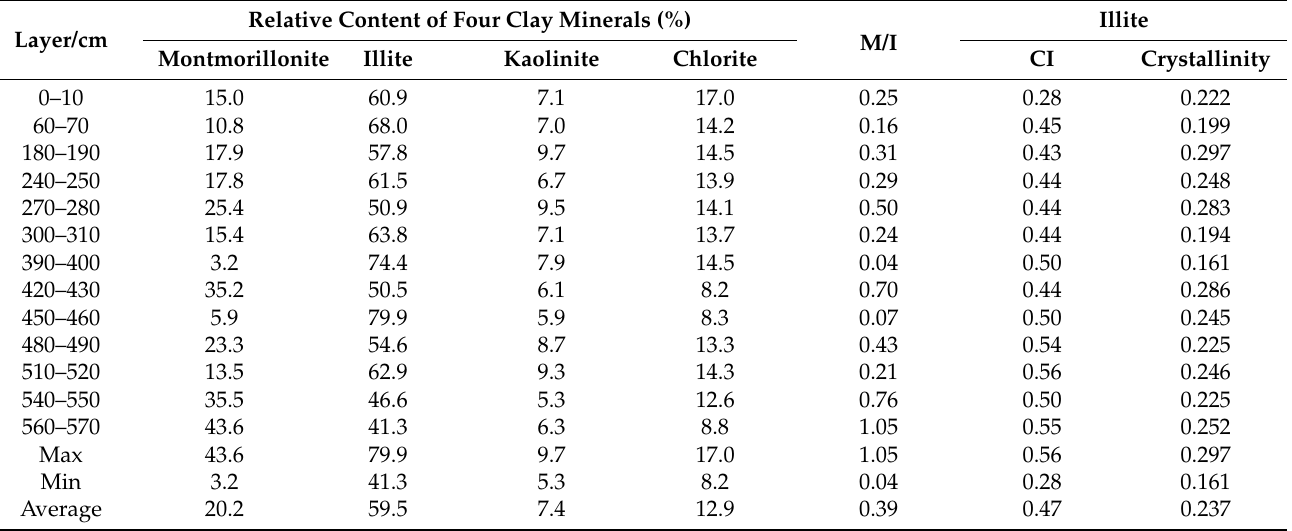
Table 1. Clay minerals compositions of